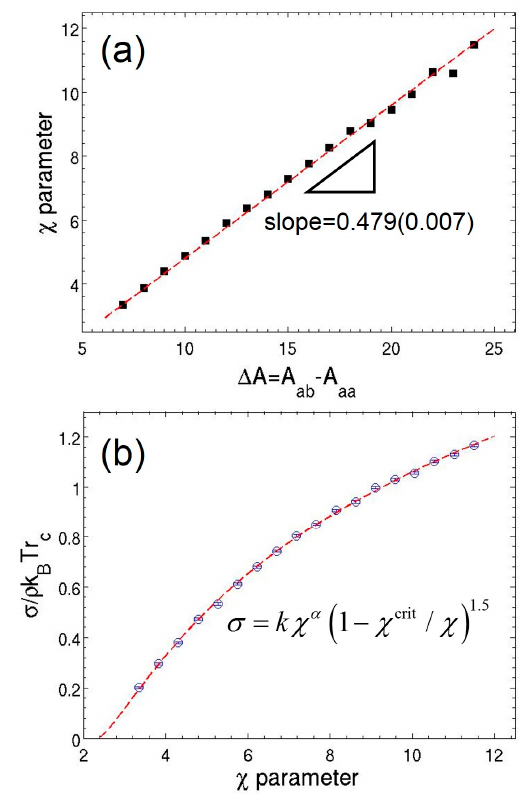
Figure 1. ( a ) Relation between effective χ parameter and excess repulsion between unlike species in a binary mixture of monomers defined as ∆ A = A ab − A aa , where a and b represent the types of interacting beads. The dash line is the least-square linear fitting. ( b ) Simulated surface tension of the binary mixture as a function of χ parameter. The smooth curve is a fit to a 3/2 power law with a non-classical critical point.